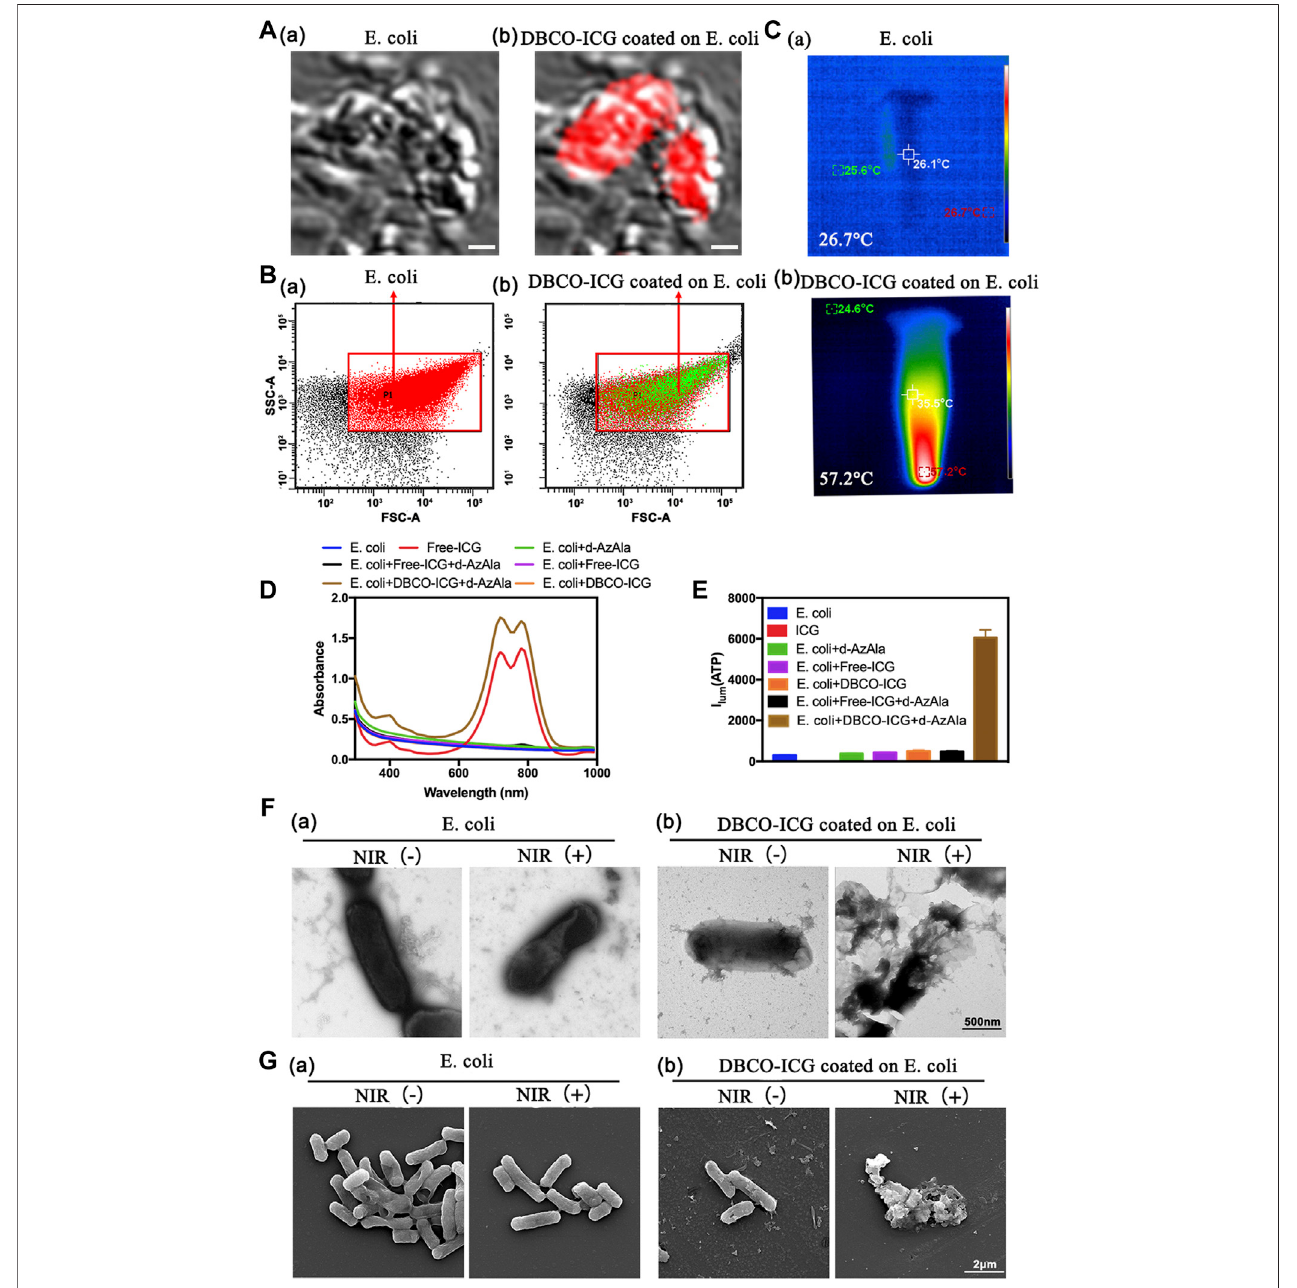
FIGURE 2 | Sulfo-DBCO-ICG effectively coated on d-AzAla-bacteria and measured the ATP bioluminescence from the lysed bacteria. (A) CLSM images of E. coli (a) and D-ICG coated on E. coli (b). (B) Flow cytometric quanti fi cation of conjugation with E. coli by DBCO-ICG (C) Photothermal images of E. coli (a) and DBCO-ICG coatedon E.coli after90s(b). (D) UV – Vis-NIRabsorbancespectraof E.coli ,Free-ICG, E.coli +d-AzAla, E.coli +Free-ICG, E.coli +DBCO-ICG, E.coli +d-AzAla+Free- ICG, and E. coli + d-AzAla + DBCO-ICG. (E) ATP detector measure the ATP bioluminescence of E. coli , Free-ICG, E. coli + d-AzAla, E. coli + Free-ICG, E. coli + DBCO-ICG, E. coli +d-AzAla +Free-ICG, and E. coli + d-AzAla + DBCO-ICG. (F) TEM images ofbacteriafollowing NIR irradiation. (a) Bacteria in the absence of DBCO- ICG conjugates. (b) Targeted photothermal lysis of bacteria by DBCO-ICG conjugates in the presence and absence of NIR irradiation. (G) SEM images of bacteria following NIR irradiation. (a) Bacteria in the absence of DBCO-ICG conjugate. (b) Targeted photothermal lysis of bacteria by DBCO-ICG conjugates in the presence and absence of NIR irradiation. The laser used in all the aforementioned measurements is an 808 nm NIR laser with a power intensity of 2 W cm − 2 .